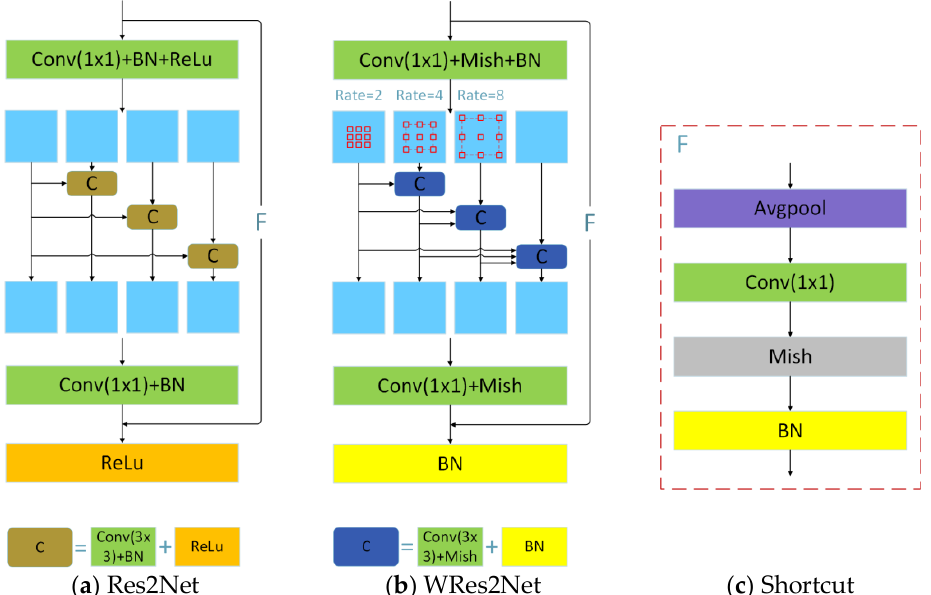
Figure 5. ( a ) is the Res2Net module, ( b ) is the WRes2Net module, ( c ) is the WRes2Net shortcut Rate is the dilation rate, and Avgpool is the average pooling layer.